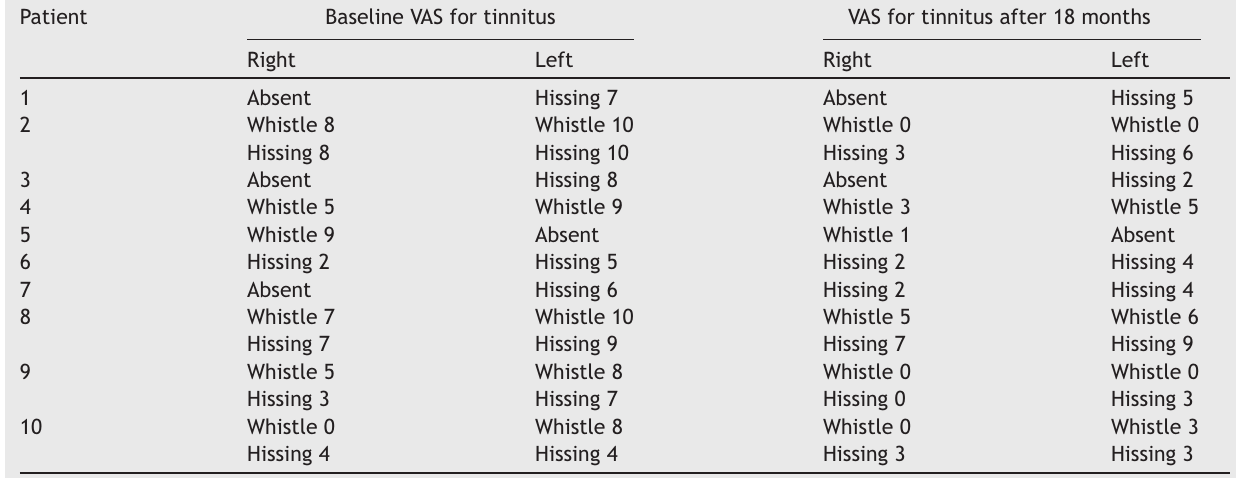
Visual analog scale (VAS) scores according to type of tinnitus in the beginning and at the end of sound therapy.